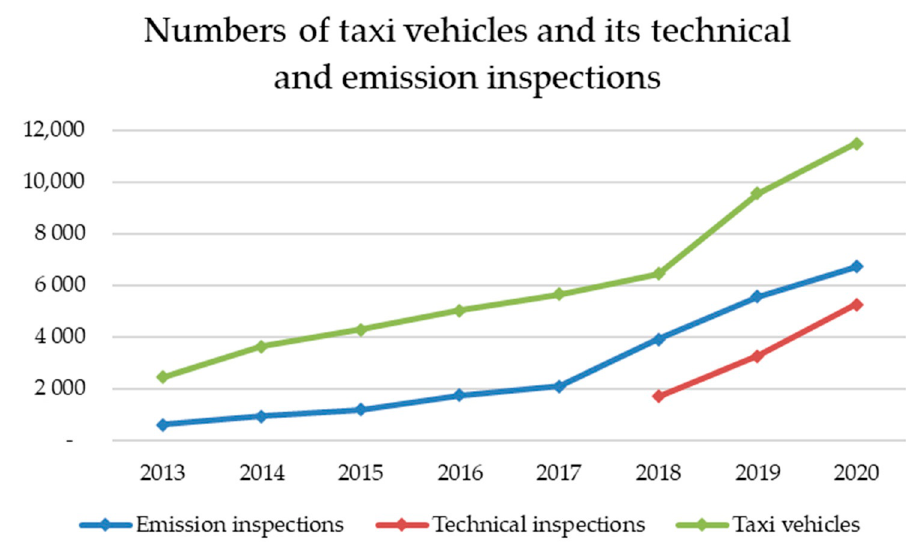
Figure 3. Taxi vehicles and their technical and emission inspections.